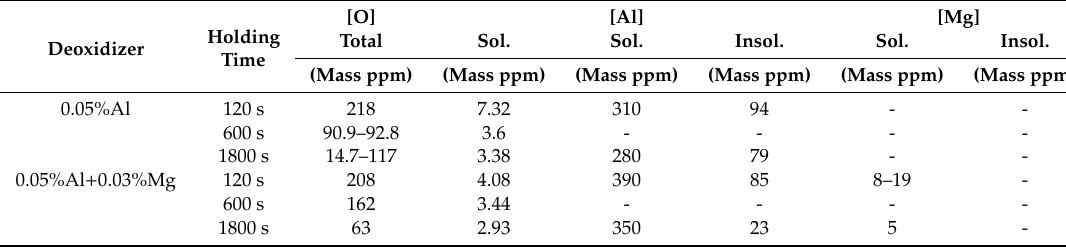
Table 2. Chemical composition of melt.